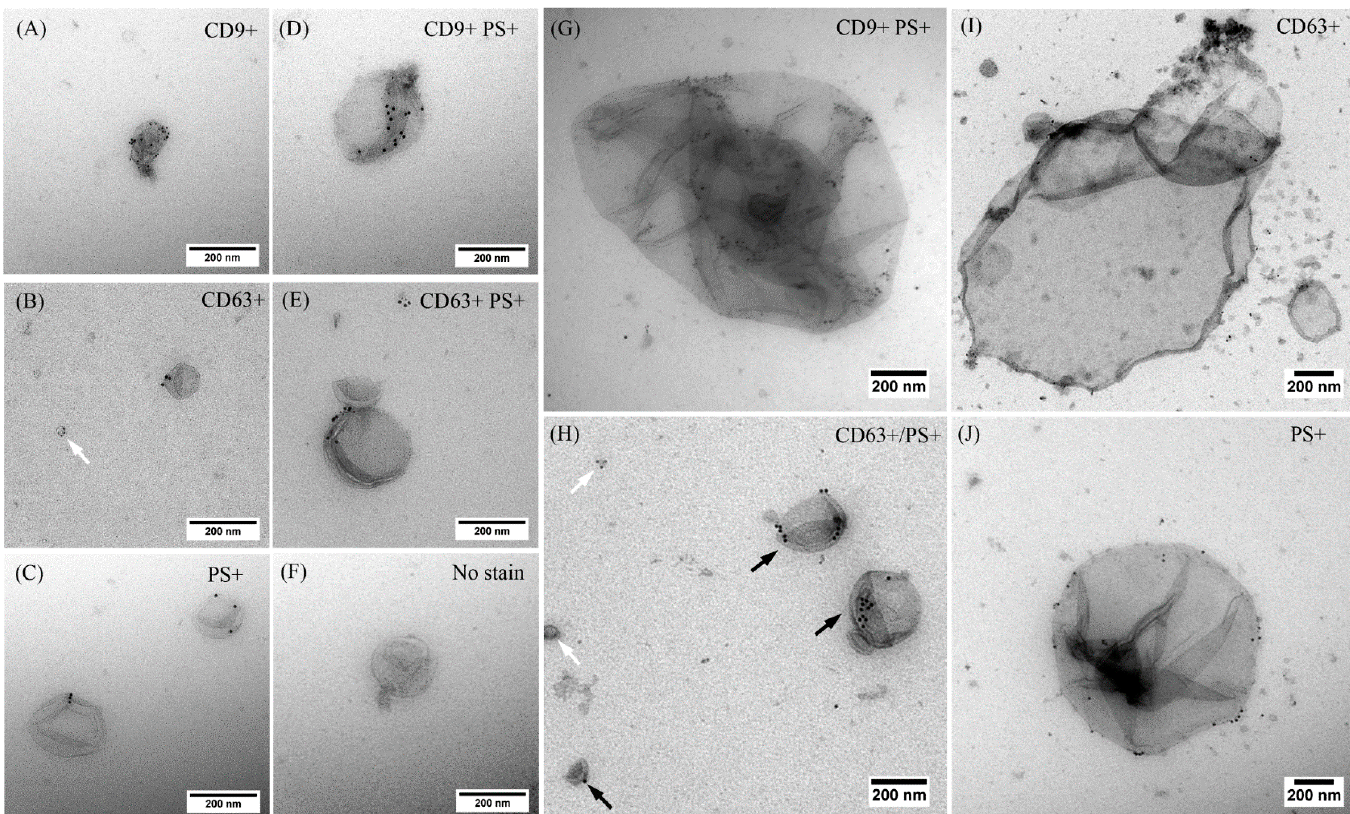
Figure 2. Representative EM images showing immunogold labeling of EVs using anti-CD9 or -CD63 antibody and lactadherin. Both antibodies were coupled with 6-nm gold, whereas lactadherin was coupled with 10-nm gold. EVs were derived from conditioned media of FaDu cells collected at 4 h after microbubbles-assisted ultrasound (USMB) treatment. EVs were stained positive by anti-CD9 antibody ( A ), anti-CD63 antibody ( B , H white arrows, and I ), or lactadherin, a surface marker of the negatively charged phospholipid, phosphatidylserine (PS+; C , H black arrows, and J ) only. Some were double stained by anti-CD9 antibody and lactadherin ( D , G ) or anti-CD63 antibody and lactadherin ( E ). EVs without gold label were also detected ( F ). Large EVs with an apparent diameter of 500–1200 nm were also detected ( G , I , J ).